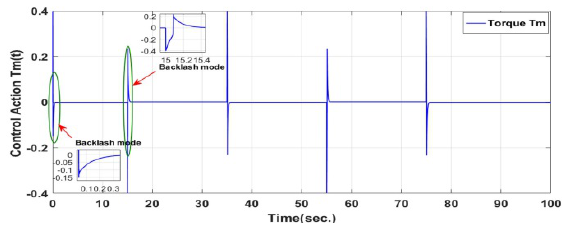
Figure 13. Backlash and contact modes of the system behavior